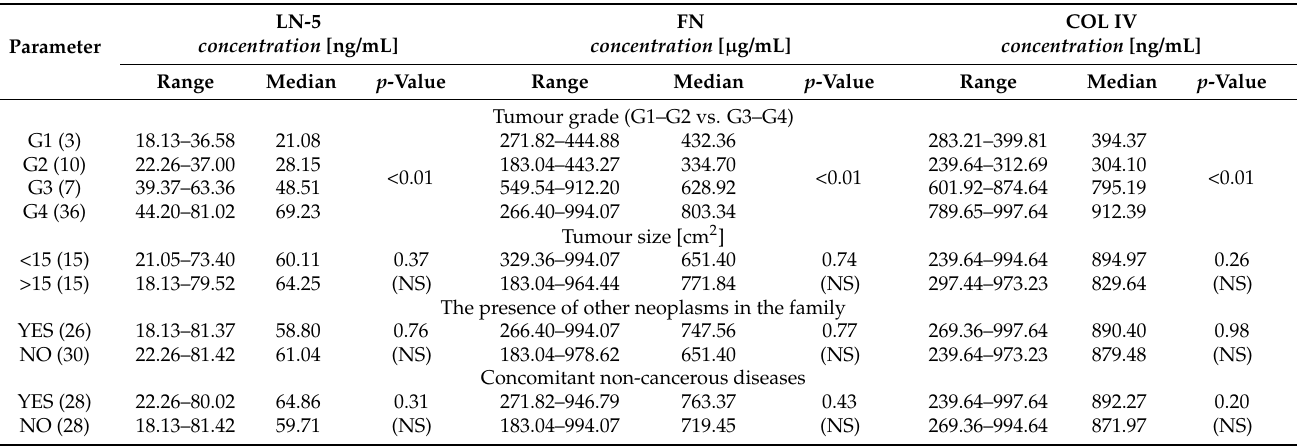
Table 3. Changes in LN-5, FN, and COL IV concentrations in comparison with the available clinical data for the samples from patients.